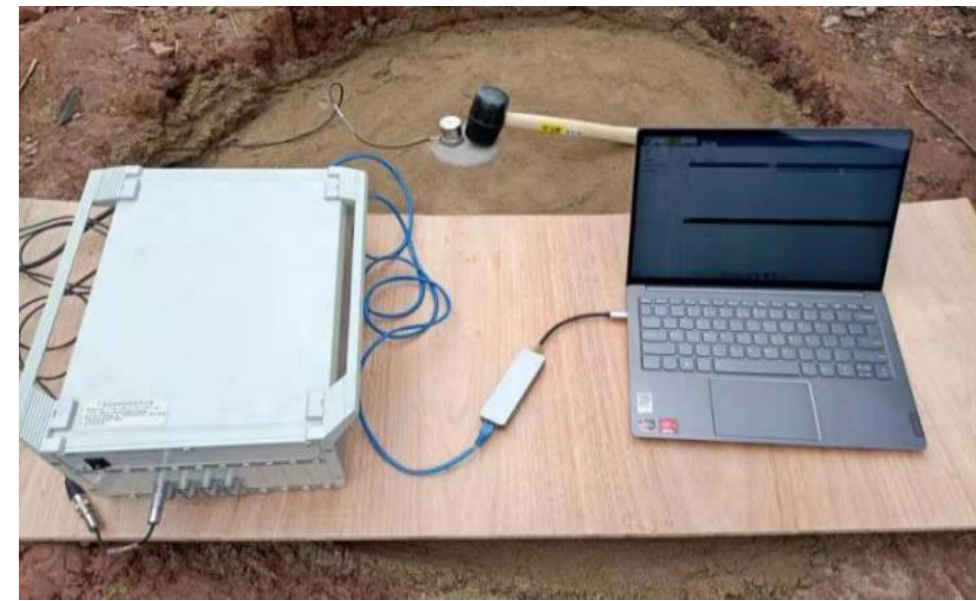
Figure 8. Pile integrity testing field.